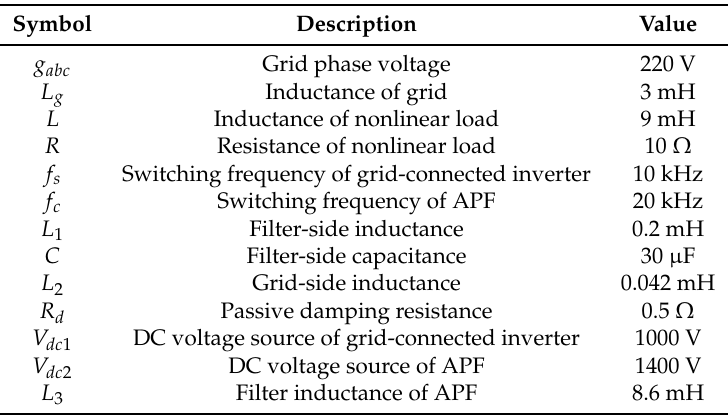
Table 3. Circuit parameters.